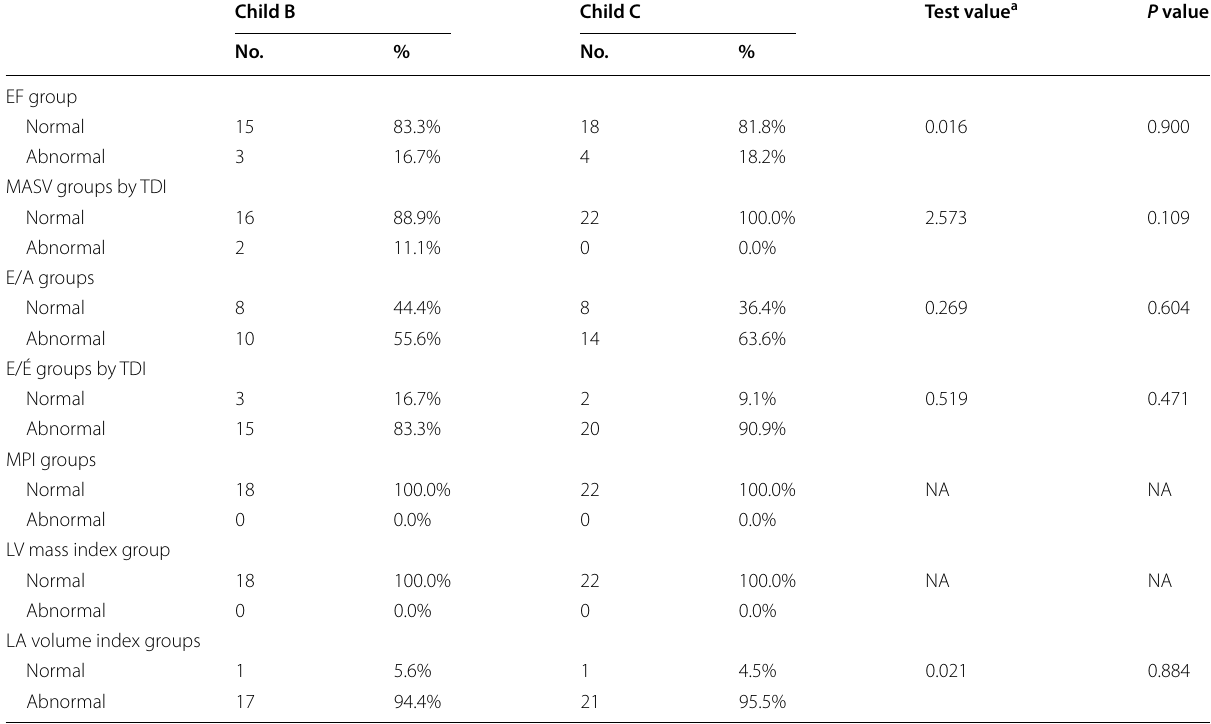
Table 4 Comparison of echocardiographic data between child B and child C patients